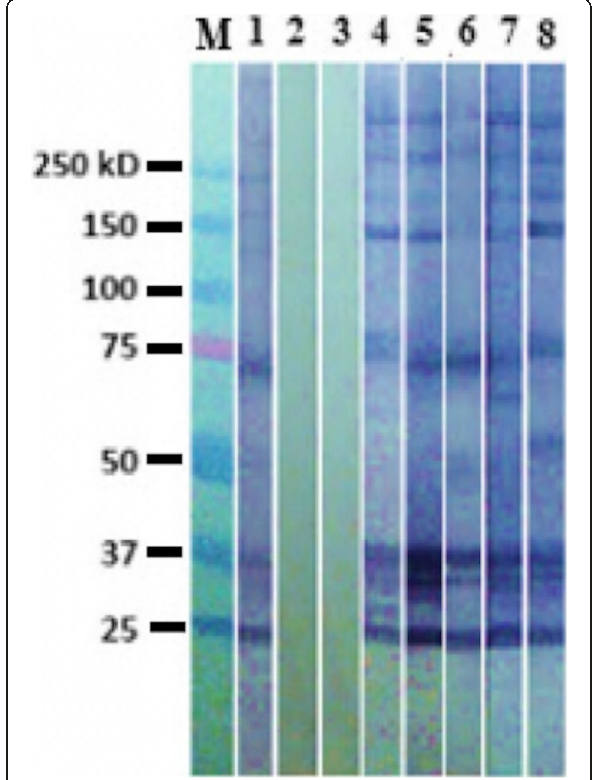
antibodies against T. cruzi in dogs positive to indirect ELISA. Lane M: molecular weight marker Biorad cat. 161 – 0373 All Blue 250 kD; lane 1: positive control (serum from a dog confirmed as positive); lane 2: negative control (serum from a dog confirmed as negative); lane 3; control of dog anti-IgG; lanes 4 – 8: samples of owned dogs in the metropolitan area of Merida, Yucatan, reactive to T.